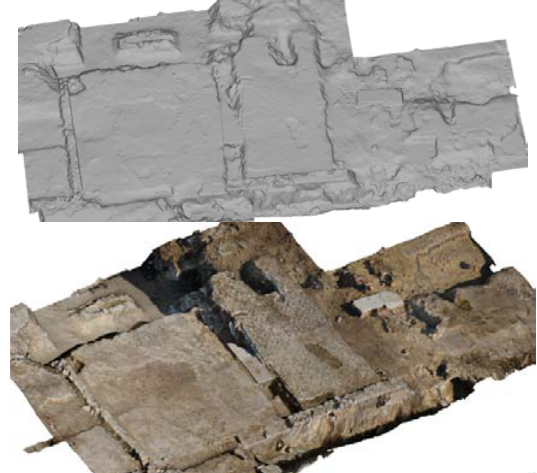
Figure 5.Complete triangulated 3D model of the surveyed area (top), view of the realized textured model (below).